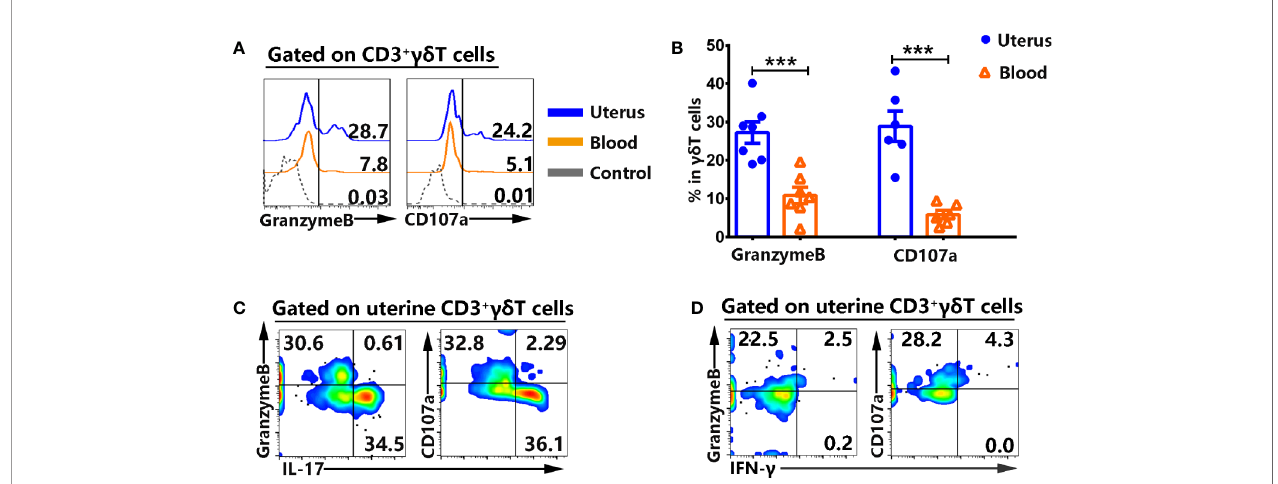
FIGURE 5 | gd T cells from uterus highly expressed cytotoxic molecules and did not co-express IL-17. Uterus and blood mononuclear cells were stained, gated on CD3 + gd T + cells and analyzed by fl ow cytometry for the expression of cytotoxic molecules. The expression of GranzymeB and CD107a was assessed after intracellular and cell surface staining by FACS. The representative histogram graph (A) and statistical results (B) from 6-7 independent experiments with six mice in each experiment were shown. The mononuclear cells from uterus were stimulated with or without PMA plus ionomycin in the presence of BFA for 6 h and analyzed by FACS for the co-expression of IL-17, IFN- g with GranzymeB and CD107a. The graphs were representative of six independent experiments (C, D) . The data were shown as mean ± SEM. The statistical signi fi cance was determined with the Mann – Whitney U test. ***P <